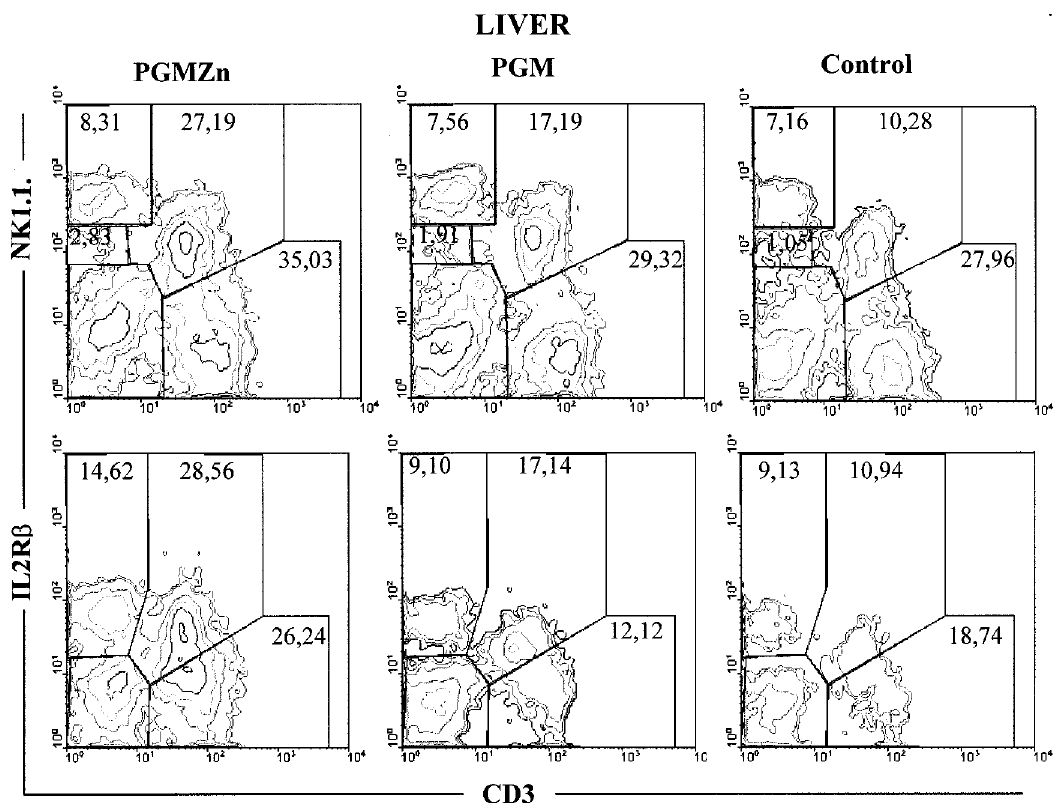
FIG. 2. FACS profiles of two-color immunofluorescence staining of hepatic MNLC after in vivo treatment with PGM-Zn, PGM or medium, shown as a representative result of three isolated experiments.